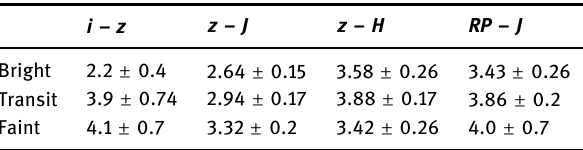
Table 2: Constraints on color indices between SDSS, 2MASS, and Gaia